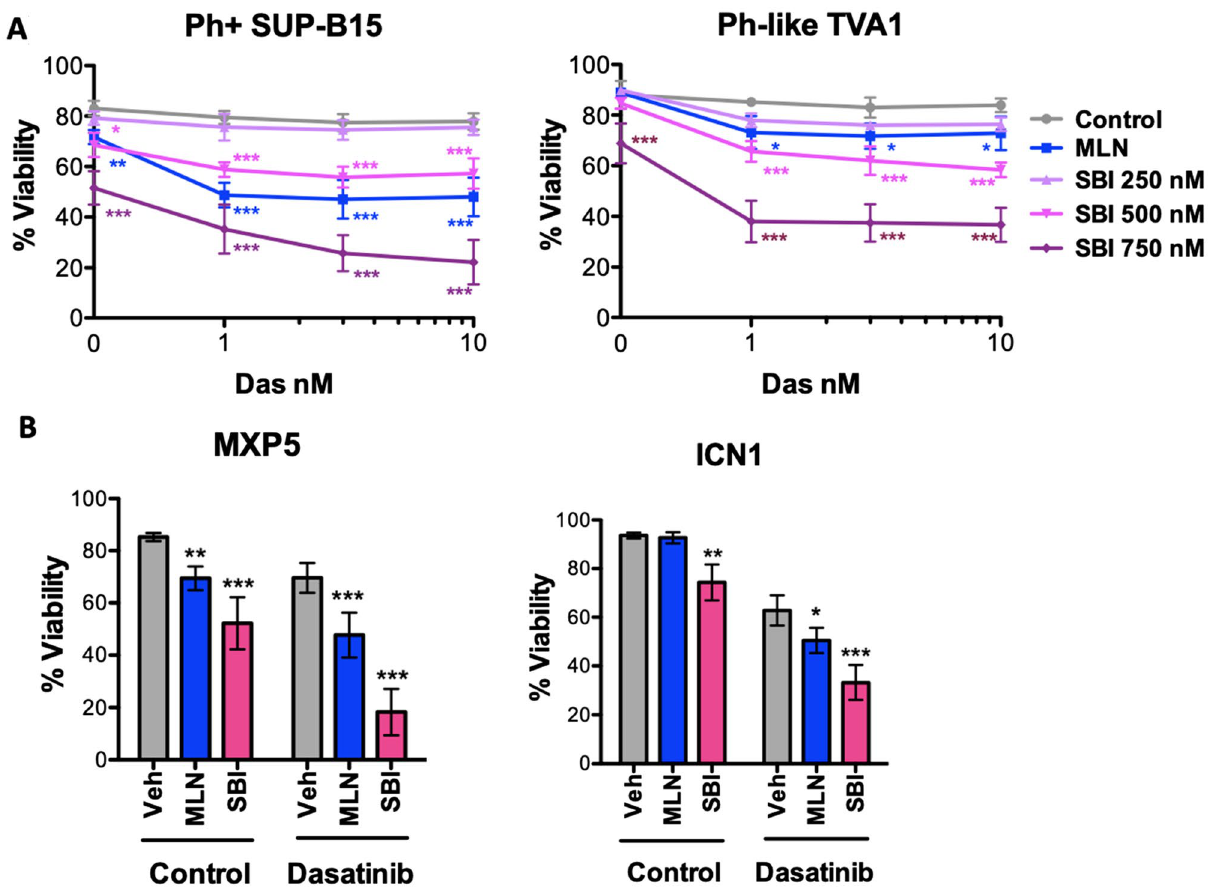
Figure 4. SBI-756 sensitizes to dasatinib in human Ph+ and Ph-like B-ALL cell lines, and stromal-dependent Ph+ B-ALL cells. ( A ) Viability assay of SUP-B15 and TVA1 cells after 48 h of treatment as indicated. (* p < 0.5, ** p < 0.01, and *** p < 0.001, n = 3–4) ( B ) Viability assay of MXP5 and ICN1 cells cultured on OP9 stromal cells. Drug concentrations: dasatinib, 10 nM (except 1 nM for MXP5); MLN0128, 100 nM; SBI-756, 750 nM. Significance was calculated for A and B using two-way ANOVA (* p < 0.5, ** p < 0.01, and *** p < 0.001, n =